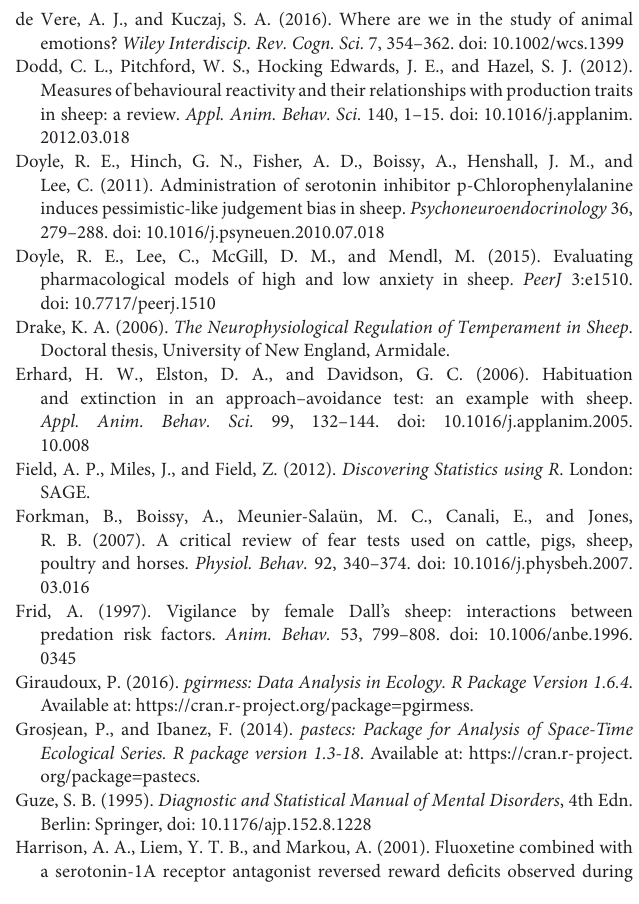
FIGURE S1 | Photograph of a sheep in side-profile. The photograph was printed to be approximately life-size on A0, matte, 200 gsm cardstock then was cut out and mounted to 5 mm thick black corflute board using spray adhesive for use in the modified attention bias